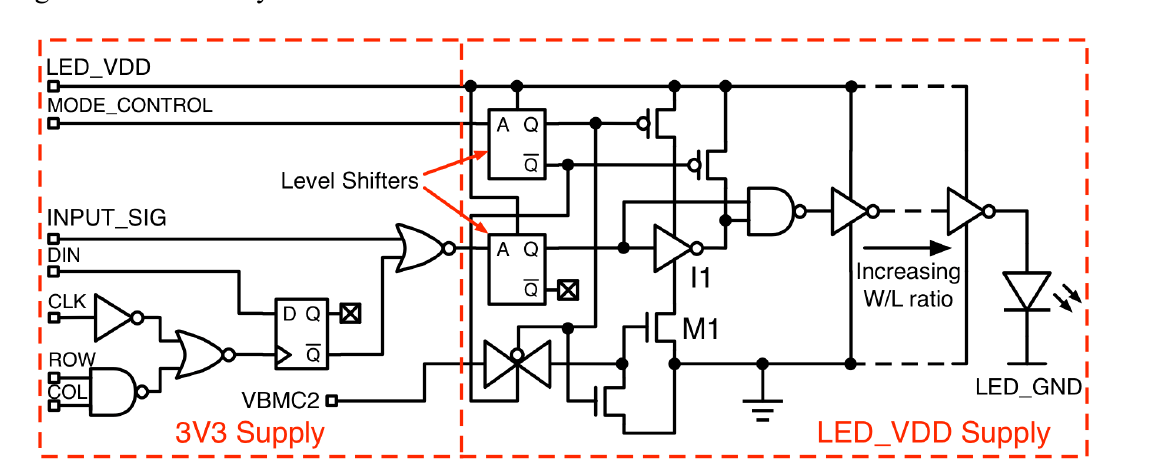
Figure 6. Shortest and longest micro-LED excitation